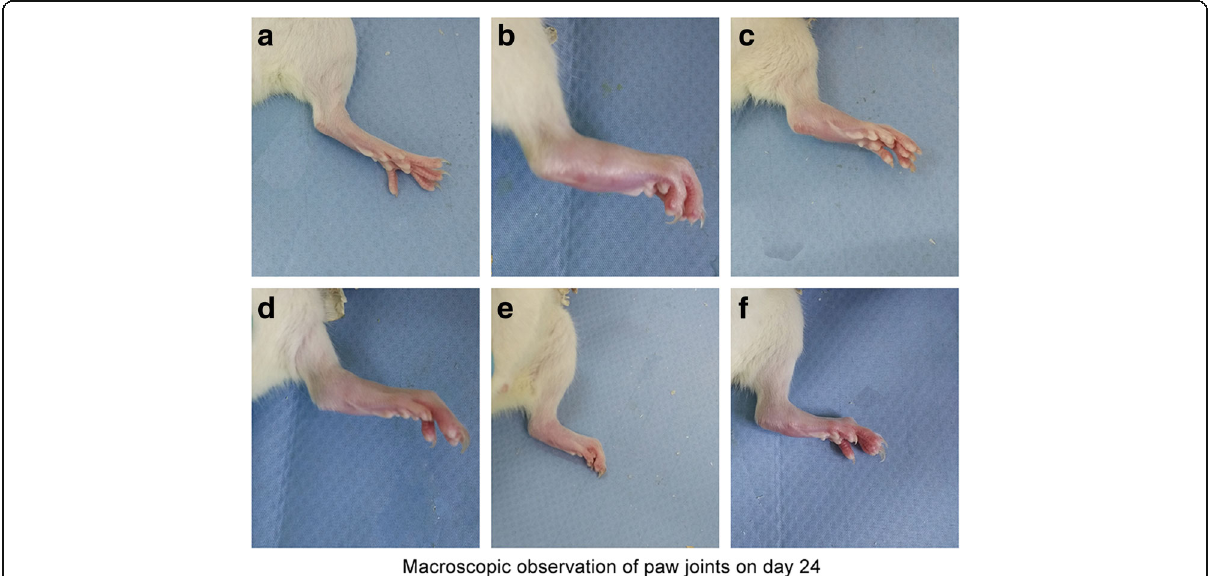
Fig. 3 Macroscopic signs of arthritis on day 28. Macroscopic signs of arthritis included swelling, redness and deformity in ankle joints. a Normal; ( b ) Model; ( c ) MTX; the TRC combination ( d ) 25 mg/kg; ( e ) 50 mg/kg; ( f ) 75 mg/kg. Compared with Normal ( a ), obvious arthritis symptoms of erythema and edema were observed in Model ( b ). Different dose ( d , e , and f ) could relieve the arthritis symptoms and the high dose